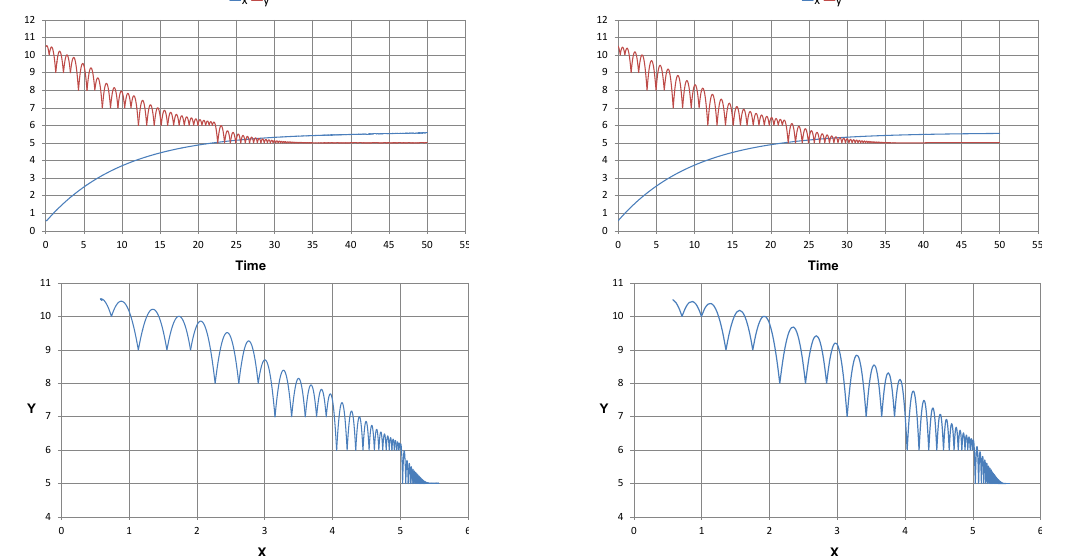
Figure 5: On left the results from SAHISim are shown, on right are the results obtained from OpenModelica. most important change is to be able to rewind the solver to the previously calculated state. If professional solvers can incorporate this change, then it will enable their use in SAHISim framework, making it even more